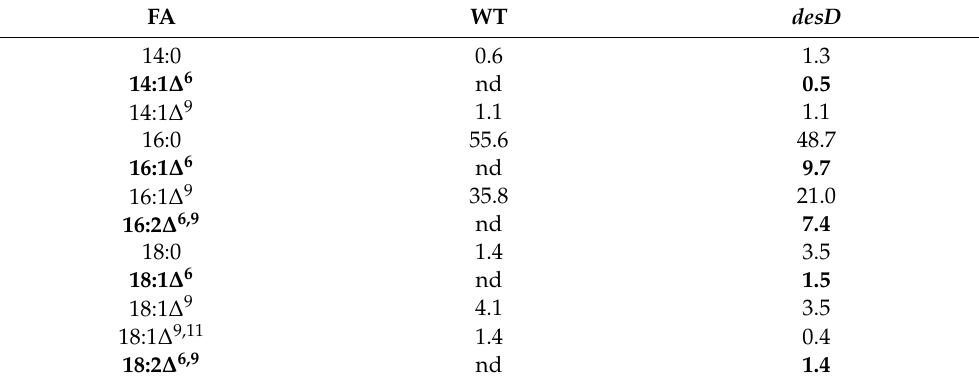
Figure 1. Separation of fatty acids methyl esters obtained from total lipids of strain Synechococcus elongatus PCC 7942 by variants (total ion chromatograms): ( a ) wild type cells; ( b ) cells expressed the desD ( sll026 ) gene (grey plate) and, supposedly, desaturated FAs at position ∆ 6 . Table 1. FA composition (%) of S. elongatus (WT) and its trasformant that expressed the desD gene.